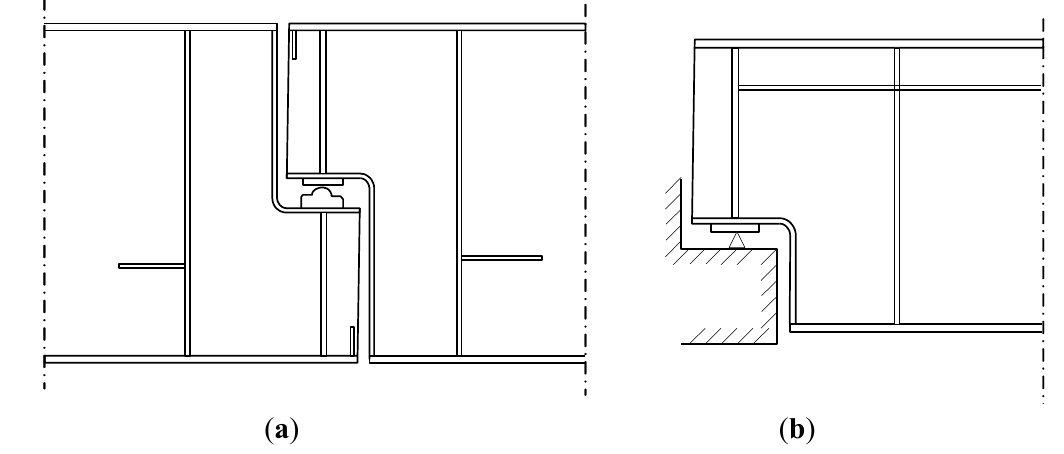
Figure 3. Bridge girders with reduced height are common in: ( a ) Gerber bridges; and ( b ) At bridge supports.